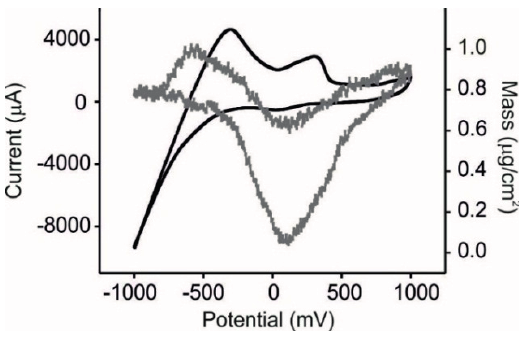
Figure 2. Response of the array of sensors towards catechol 10 − 3 mol·L − 1 in KCl 0.1 mol·L − 1 . Voltammetric output (black line) and mass output (grey line) for the NiPc SO3 /PAH